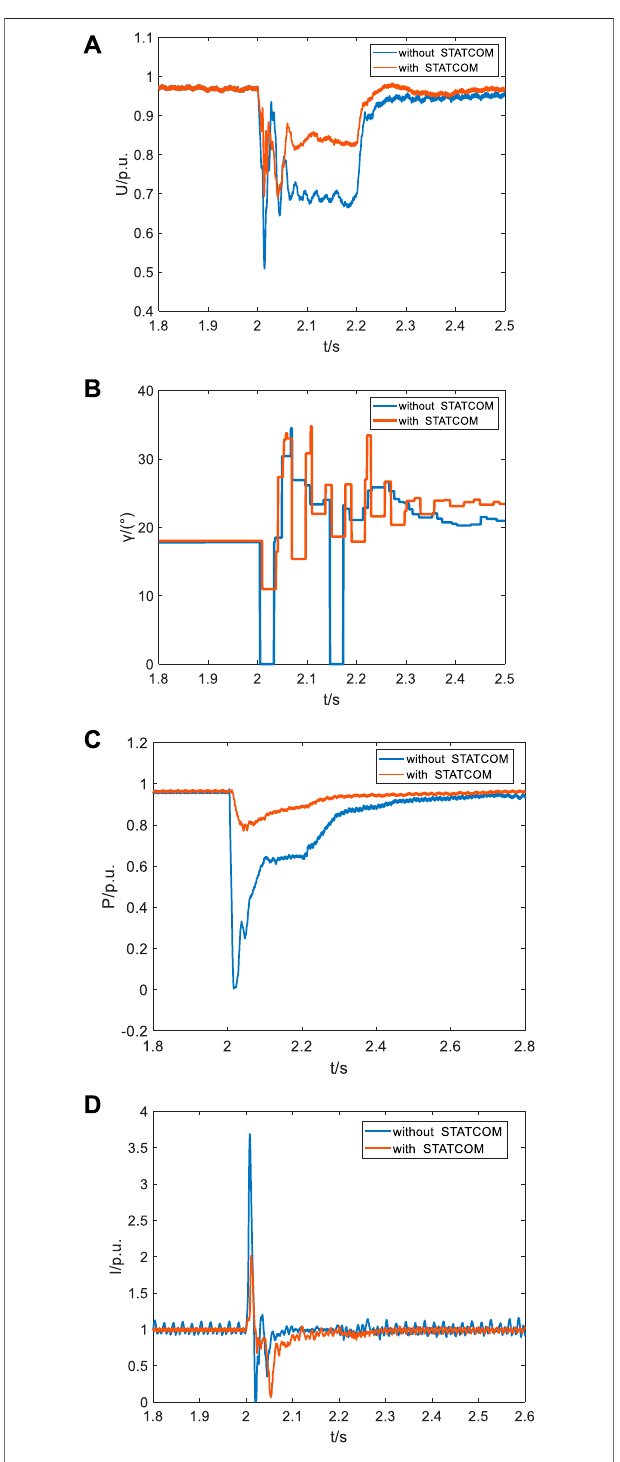
FIGURE 11 | Typical Characteristic quantities of three-phase fault. (A) Effective value of the AC voltage on the inverter side in three-phase fault. (B) Extinction angle of commutation failure in three-phase fault. (C) System transmission power in three-phase fault. (D) System DC in three- phase